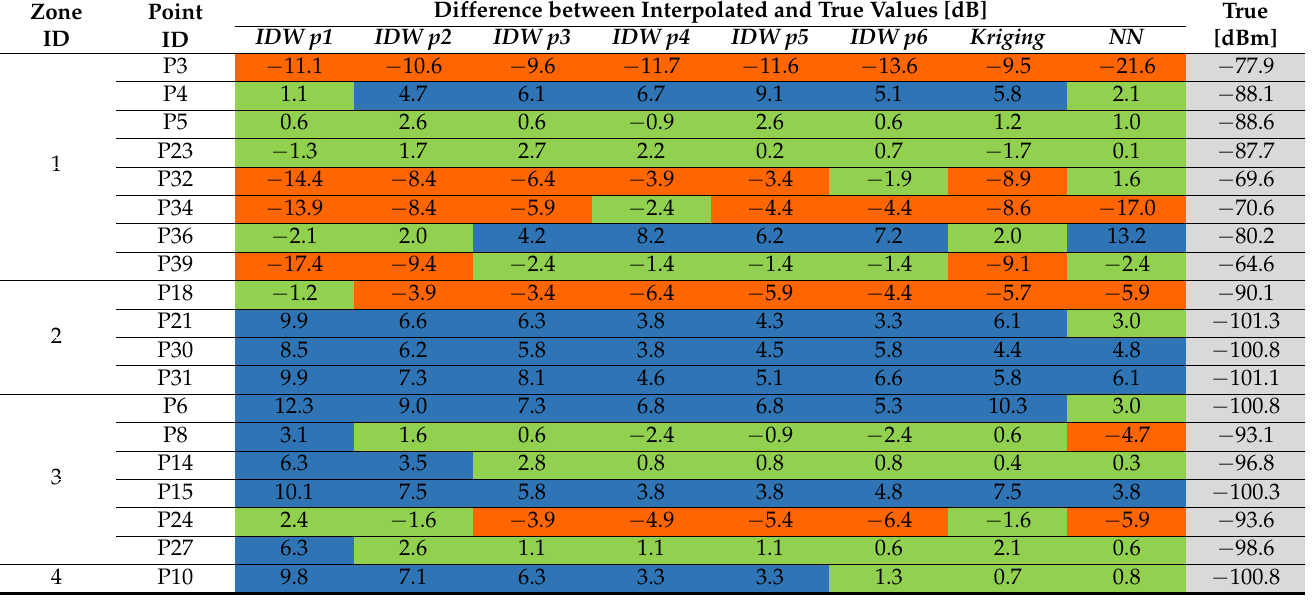
Table 4. Difference between interpolated and true value for 19 control points and various interpolation methods (Test_20c). Zone ID